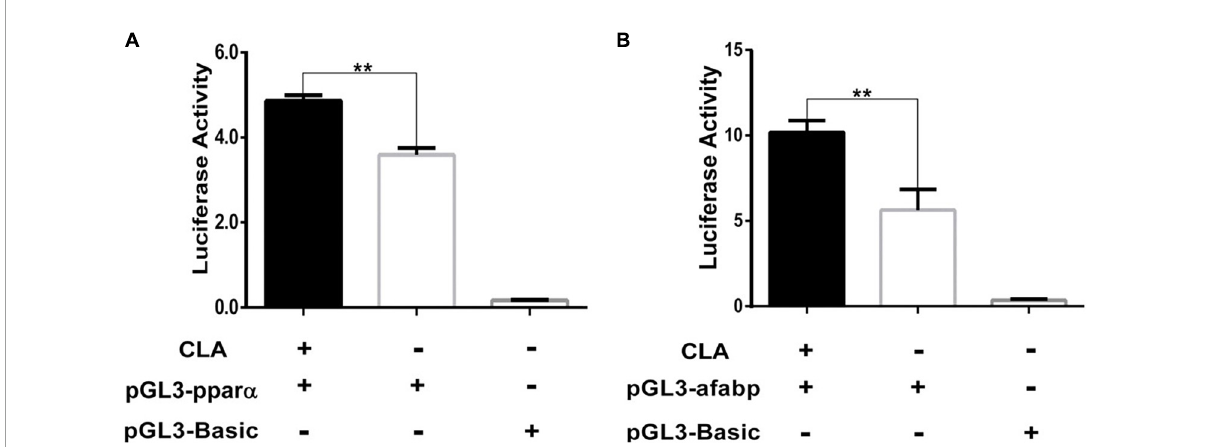
FIGURE1 Conjugated linoleic acid (CLA) enhanced the activity of PPAR α and A-FABP promoter. (A,B) The 293T cells was plated in 24-well plates and then transfected with pGL3-ppar α , or pGL3-afabp, and pGL3-Basic, pRL-TK. After 4 h, the cells were treated with CLA at a 100 µ M final concentration. Dual luciferase reporter gene system was used to measure the activity of PPAR α and A-FABP promoter. Data were analyzed by t -test. ** P < 0.01.